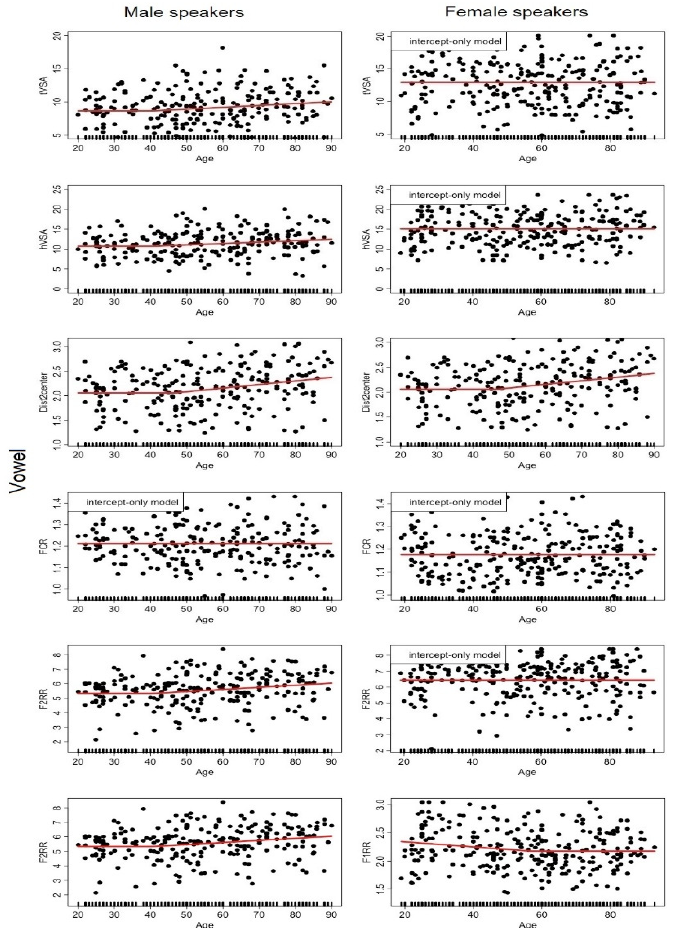
Figure A3. Dot plot of each descriptor ( y -axis) capturing aspects of the VOWEL ACOUSTICS dimension as a function of age ( x -axis) for the male ( left ) and female ( right ) speakers. The hinge function of the MARS model is represented by the red curve. Each dot corresponds to a speaker.